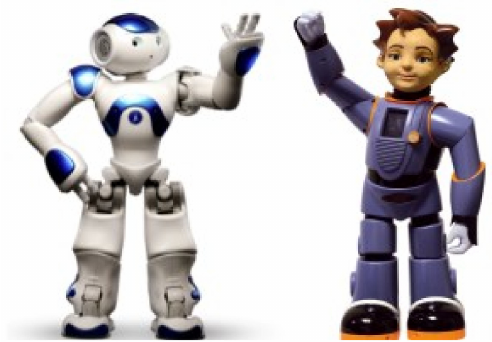
Figure 1. Robot NAO ( left ), robot Milo ( right ).